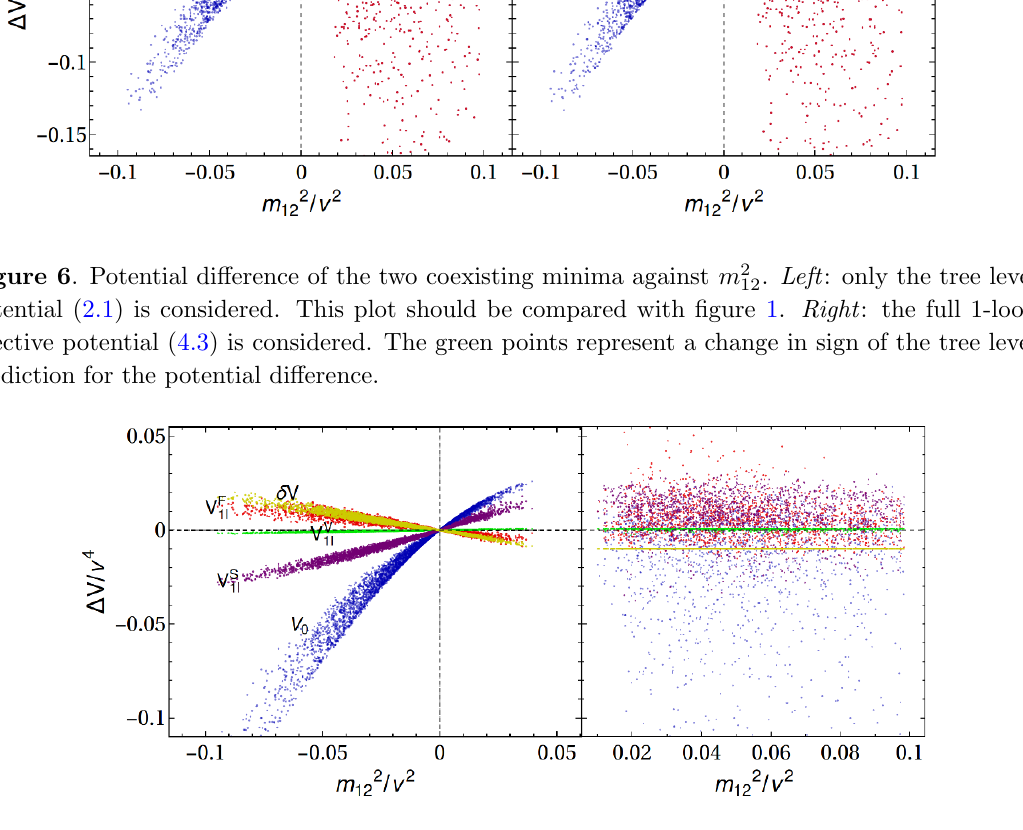
Figure 7 . Di(cid:11)erent contributions coming from the tree level potential (blue), (cid:14)V (yellow), fermions (red), scalars (purple), and vectors bosons (green) to the one-loop potential di(cid:11)erence of the right panel of (cid:12)gure 6. In the left plot only regular points are considered while the right plot shows the behavior of the non-regular